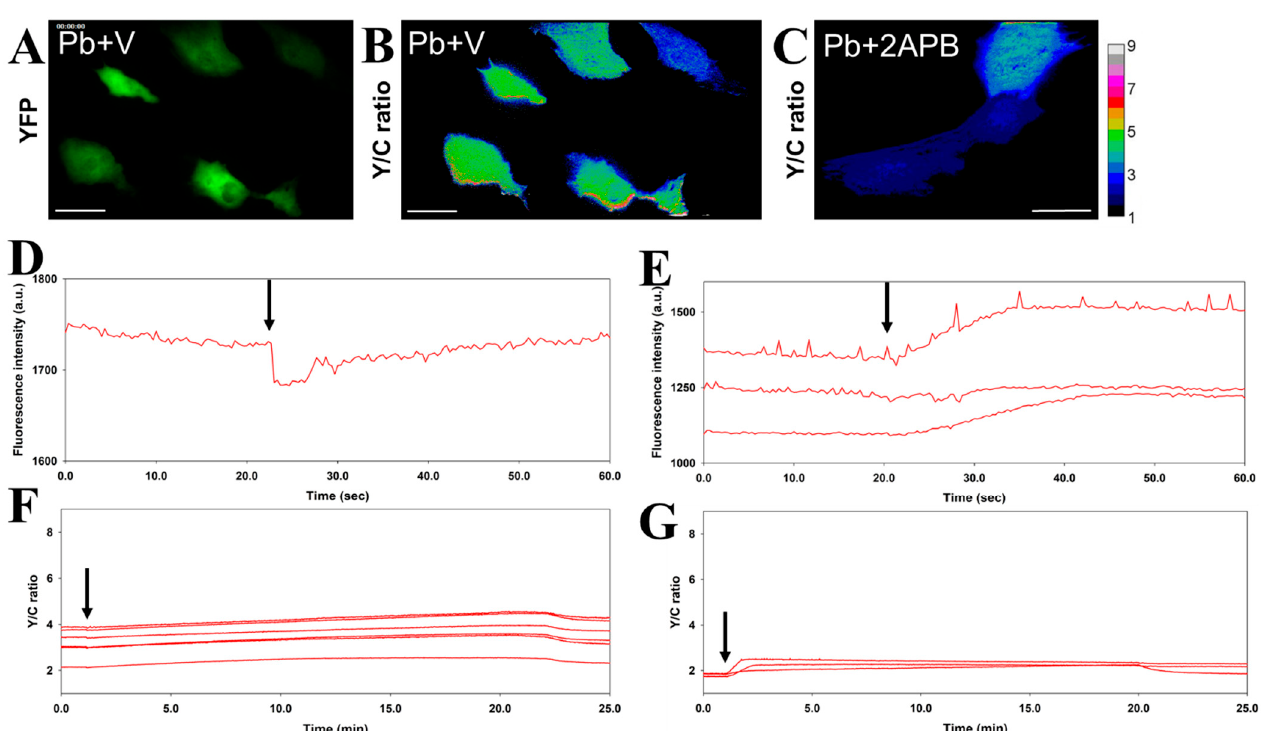
ratio increase ) could be observed in control ( F ) and Pb ( G ) treatments. Buffer without (Control) or with Pb (Pb) was intro- duced at the time points indicated by arrows.